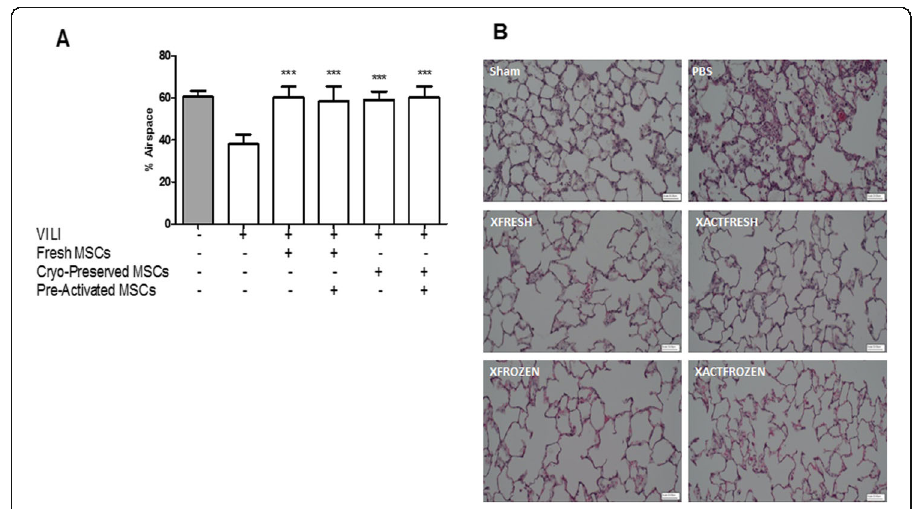
Fig. 4 Pre-activated, cryopreserved, XF-hMSCs restore lung structure. All cell treatment groups significantly restored the percentage of alveolar airspace in VILI ( a ). Representative images of lung histology sections are provided ( b ). *** P < 0.001 versus PBS control group. Sham, n = 4; PBS control, n = 8; fresh, n = 8; fresh pre-